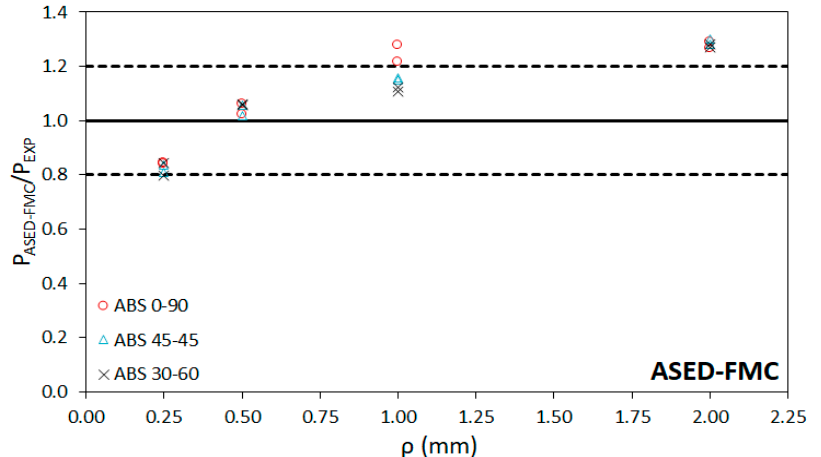
Figure 9. Comparison between fracture load predictions using ASED-FMC and experimental frac- ture loads.